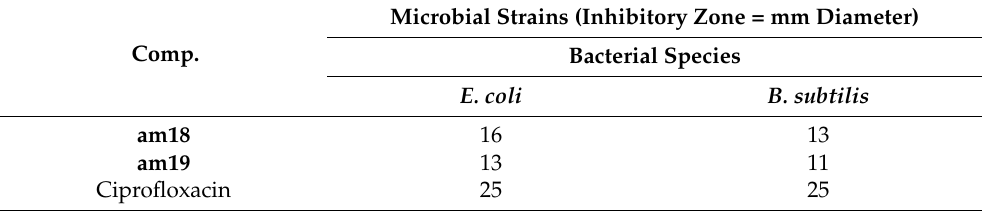
Table 10. Antimicrobial results (inhibitory zone = mm diameter) of the compounds ( am18 – am19 ).